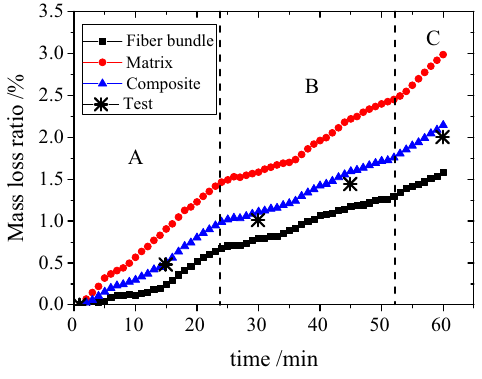
Figure 8: Mass loss ratios of components and composite calculated with FBM